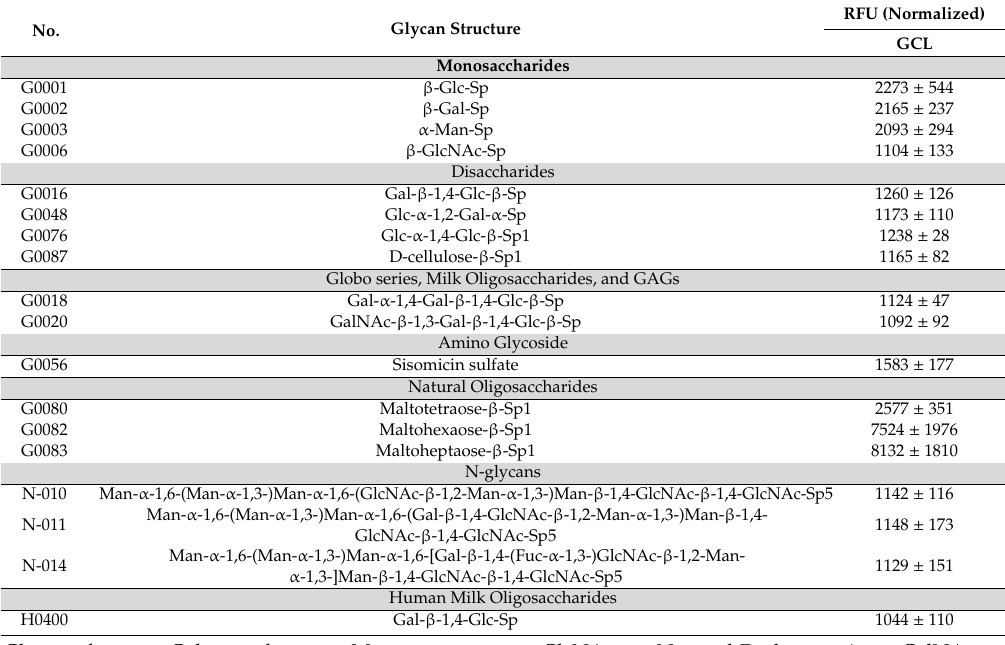
Glc = glucose; Gal = galactose; Man = mannose; GlcNAc = N-acetyl-D-glucosamine; GalNAc = N-acetyl-D-galactosamine; Fuc =